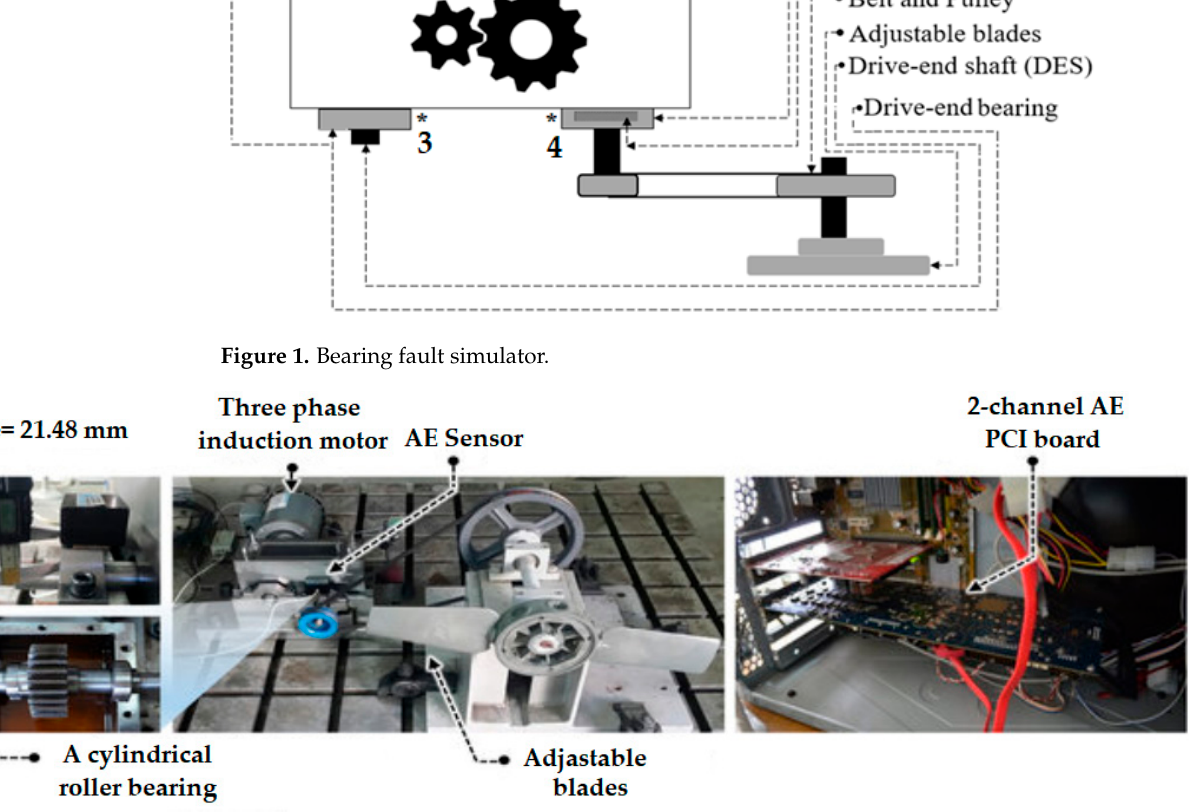
Figure 2. Experimental test for data collection in bearings: ( a ) data generation and ( b ) two-channel acoustic emission PCI board for data acquisition.